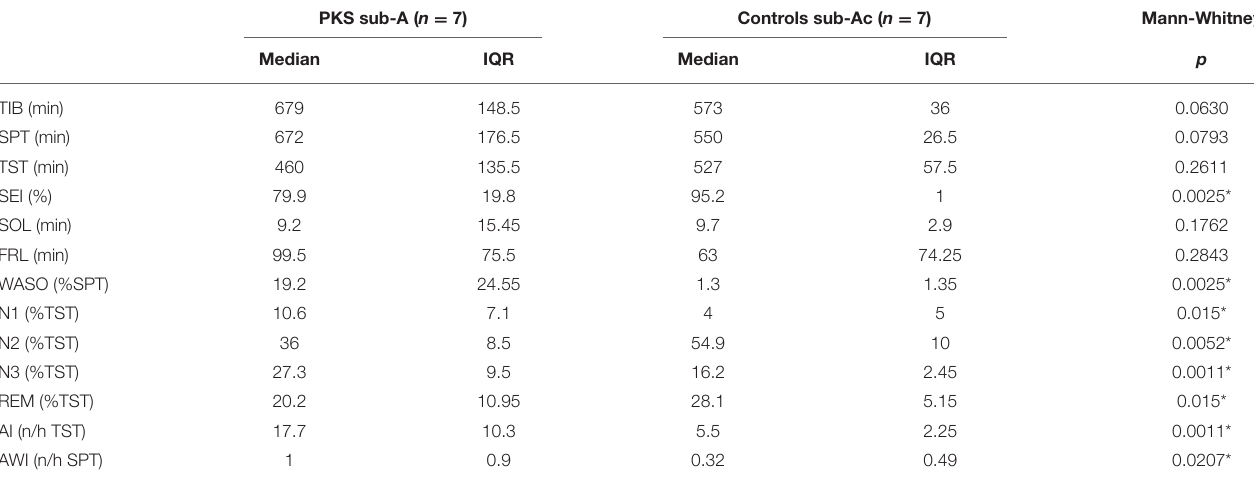
TABLE 3 | VPSG data of subgroup A (1–7 y) compared with control subgroup Ac (1–10 y). PKS sub-A ( n = 7) Controls sub-Ac ( n = 7)